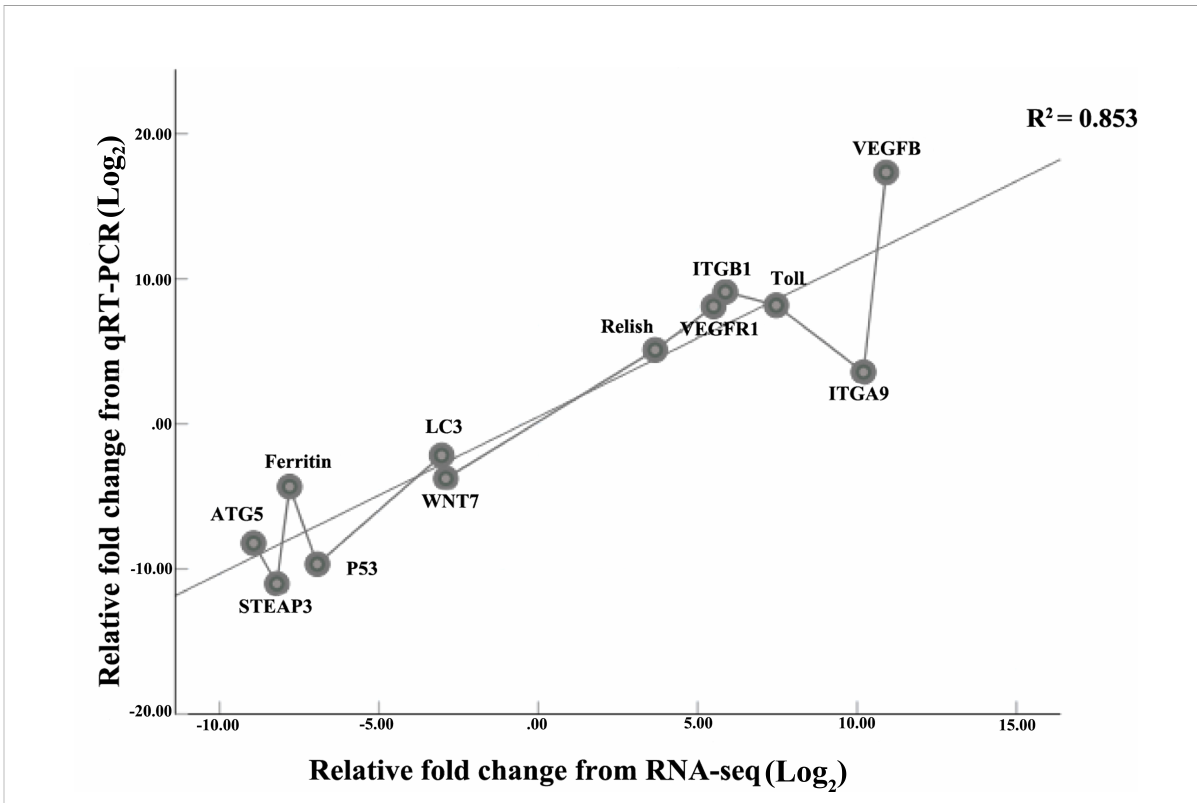
FIGURE 6 Comparisons of changes in the expression levels of selected DEUs in the intestine as determined by qRT-PCR and by RNA-Seq analysis. Also shown is the relative fold change of target gene expression levels in H. eriocheir -infected E. sinensis intestine compared to the control group. For qRT-PCR and RNA-Seq comparison, we utilised Pearson ’ s correlation analysis. The correlation coef fi cient was 0.924, p-value <0.01. VEGFB: vascular endothelial growth factor B; VEGFR, vascular endothelial growth factor receptor 1; ITGB1, integrins- b 1; ITGA9, integrins- a 9; Toll, Toll- like receptor 1; Relish; p53; Ferritin; STEAP3, six-transmembrane epithelial antigen of the prostate; LC3, MAP1LC3; ATG5, autophagy protein 5; WNT7, wntless